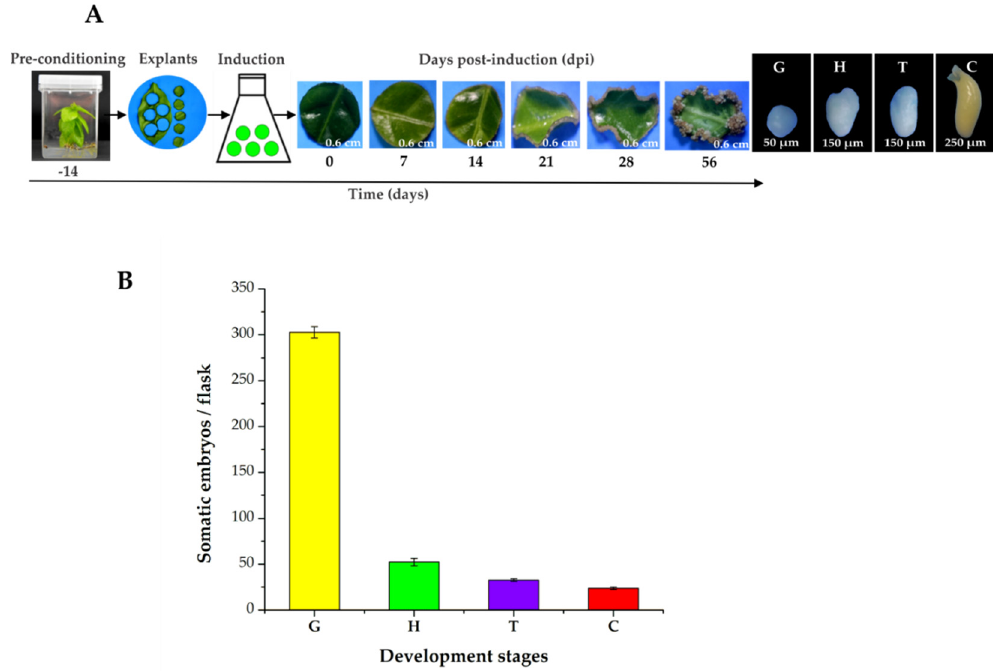
Figure 1. SE induction process in C. canephora . ( A ), On Day-14 (beginning of the pre-treatment), C. canephora plantlets were incubated in a pre-treatment medium (MS medium supplemented with NAA 0.54 µ M and Kin 2.32 µ M) for 14 days. After 14 days, explants were transferred into the induction medium (Yasuda medium supplemented with 5 µ M benzyladenine) under photoperiod conditions (16 / 8 h) for 56 dai. ( B ), Total embryo production per flask was 402.3. The values corresponding to the di ff erent developmental stages were globular (G, 298), heart (H, 48.6), torpedo (T, 31.3), and cotyledonary (C, 24.3). The bars over the columns represent the mean value ± standard error of three independent experiments.